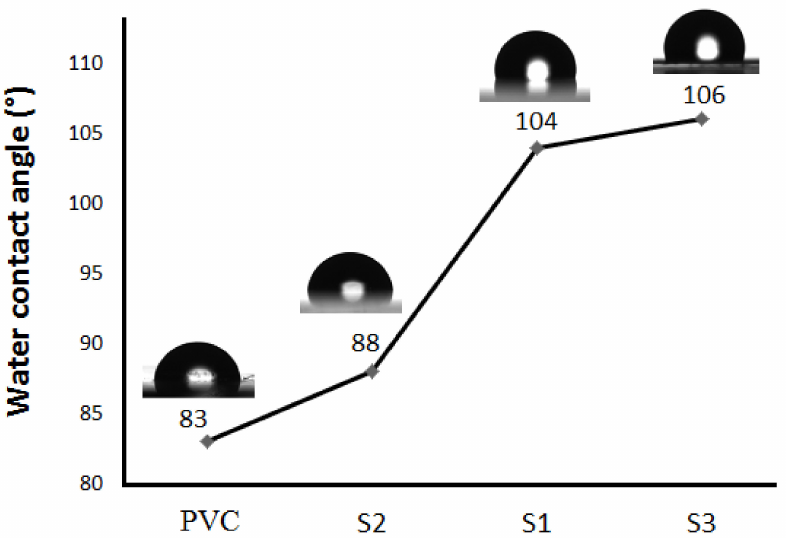
Figure 6. Values of water contact angles and profiles of water drop on films surfaces covered with sol-gel silica hybrid